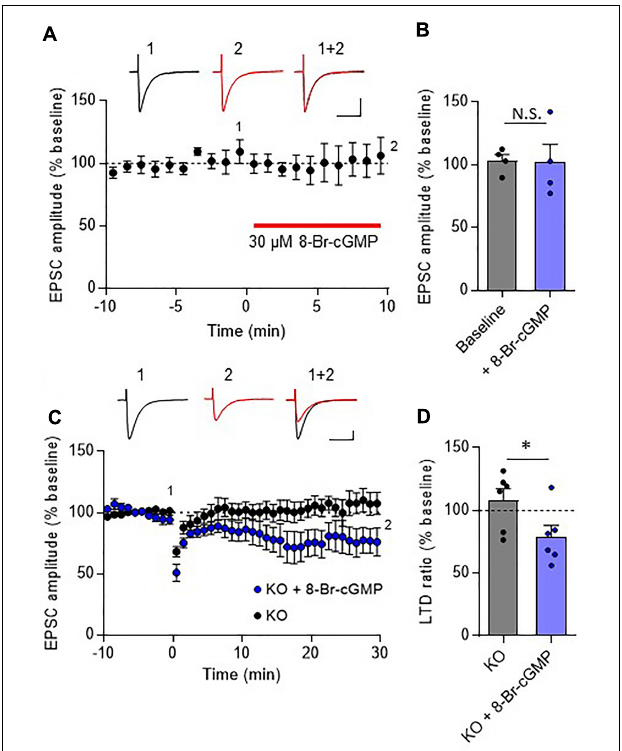
FIGURE 7 | Rescue of cerebellar LTD in TRH-deficient mice by 8-bromo-cGMP treatment. (A) Effects of 8-bromo-cGMP on baseline PF EPSCs. Thirty micromolar 8-bromo-cGMP was bath-applied to cerebellar slices for 10 min, as indicated using the red horizontal bar ( n = 4 PCs from three mice). Representative traces before (1) and 10 min after (2) the 8-bromo-cGMP treatment are shown as black and red lines, respectively. Superimposed images (1 + 2) are also shown. Scale bar: 100 pA, 50 ms. (B) Summary graph showing the effects of 8-bromo-cGMP on EPSCs, which were calculated by dividing the averaged EPSC amplitude values obtained from –5 to 0 min or 5 to 10 min by those obtained from –10 to 0 min. (C) Robust LTD in PCs from KO mice in the presence of 30 µ M 8-bromo-cGMP. Representative traces before (1) and 30 min after (2) the conjunctive stimulation is shown as black and red lines, respectively. Superimposed images (1 + 2) are also shown. Scale bar: 100 pA, 50 ms. (D) Summary graph showing depression ratios, which were calculated by dividing the averaged EPSC amplitude values obtained from 25 to 30 min by those obtained from –10 to 0 min (KO: six PCs from four mice, KO + 8-bromo-cGMP: six PCs from three mice). Data from control KO mice (C,D) , which are the same as those shown in the other figures, are presented for comparison. Asterisks indicate statistically significant differences, as determined using Welch’s t -test. ∗ P < 0.05. EPSC, excitatory postsynaptic current; KO, knock-out; LTD, long-term depression; PF, parallel fiber.